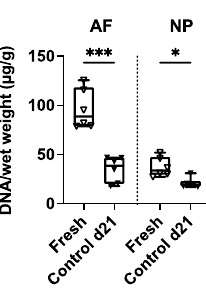
Figure A2. Cell apoptosis. Representative fluorescence microscopy images of Hoechst and TUNEL staining in the ( A ) AF and ( B ) NP after 21 days of organ culture. Cell nuclei are stained blue (Hoechst) and apoptotic cells green (TUNEL). Scale bar, 200 μm.